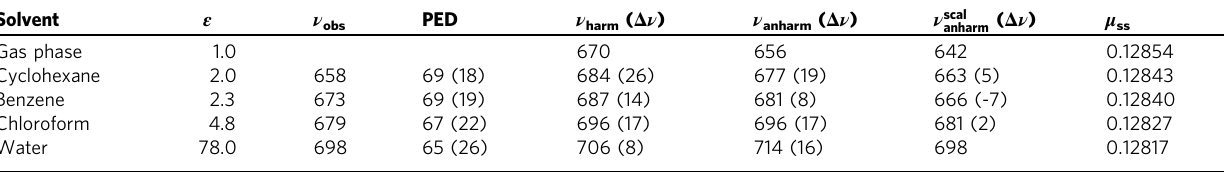
Table 2 Observed fundamental frequencies ( ν obs ), harmonic frequencies ( ν harm ), anharmonic ( ν anharm ), and scaled anharmonic ( ν scal ) vibrational frequencies calculated using the HBJ approach with rigid-bender reduced masses ( μ ss ) and scaled masses anharm ( μ ss /1.0465), respectively (frequencies given in cm − 1 , the scaling factor 1.0465 chosen to reproduce the experimental B – N fundamental frequency pertaining to water).